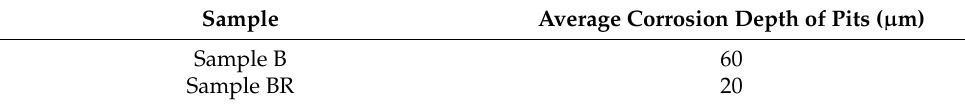
Table 2. Average depths of the corroded zones measured in the cross sections of samples B (as cast) 162 and BR (annealed) after the dealloying test.